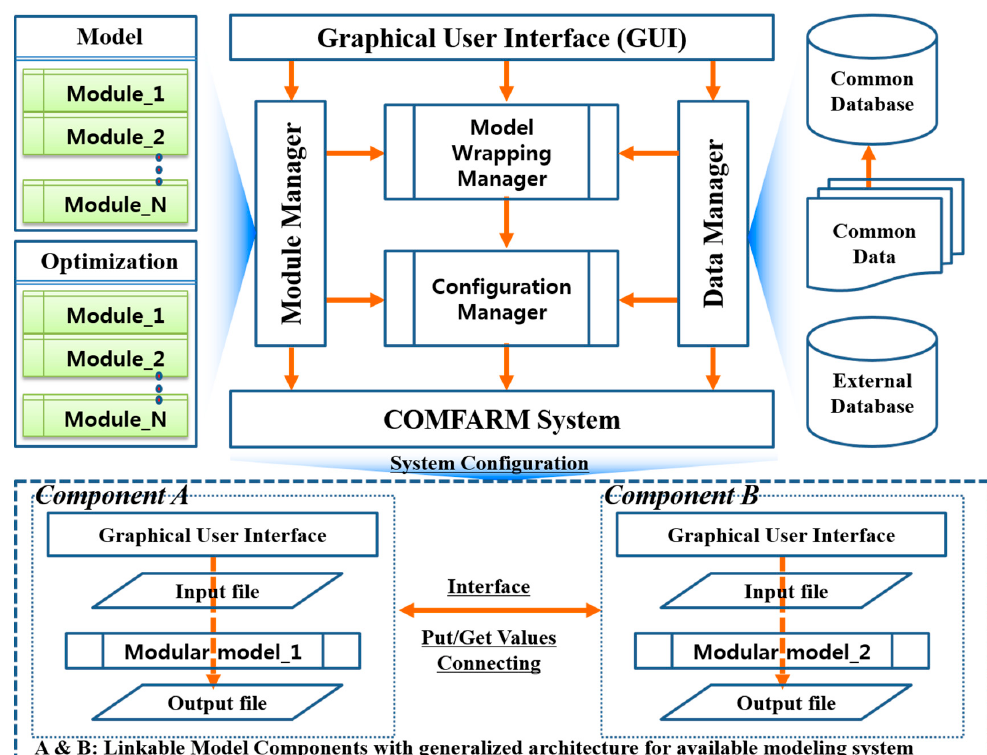
Figure 2. Schematic representation of COMFARM’s architecture. Modular models can be linked in COMFARM at various levels of complexity; a linkable model component encompasses all parts of an available modeling system with a generalized architecture. COMFARM allows modelers and users to construct and apply various modeling systems from any discipline by connecting components with modules, as indicated by the dotted rectangle.